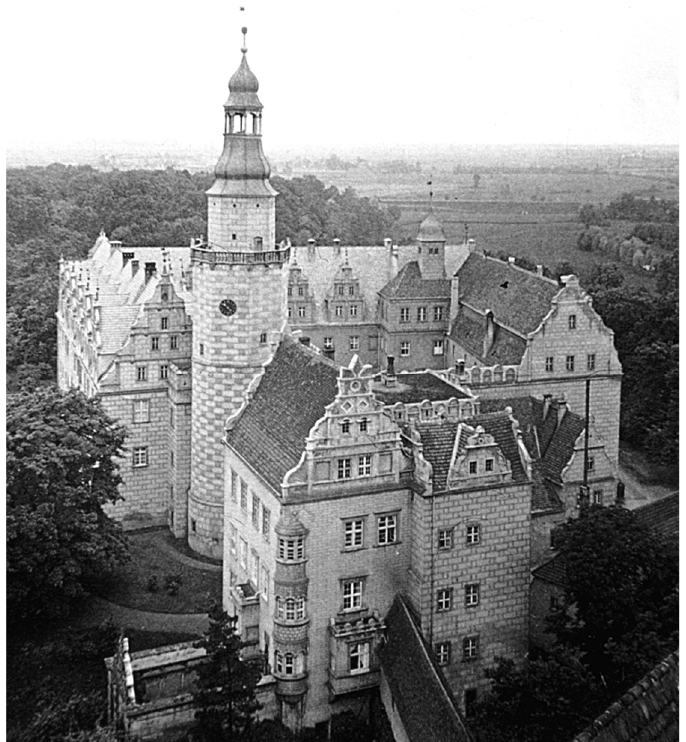
Figure 40. Sgraffito covering the façades of the castle in Oleśnica. Source: Lutsch (1903, fol. 85).